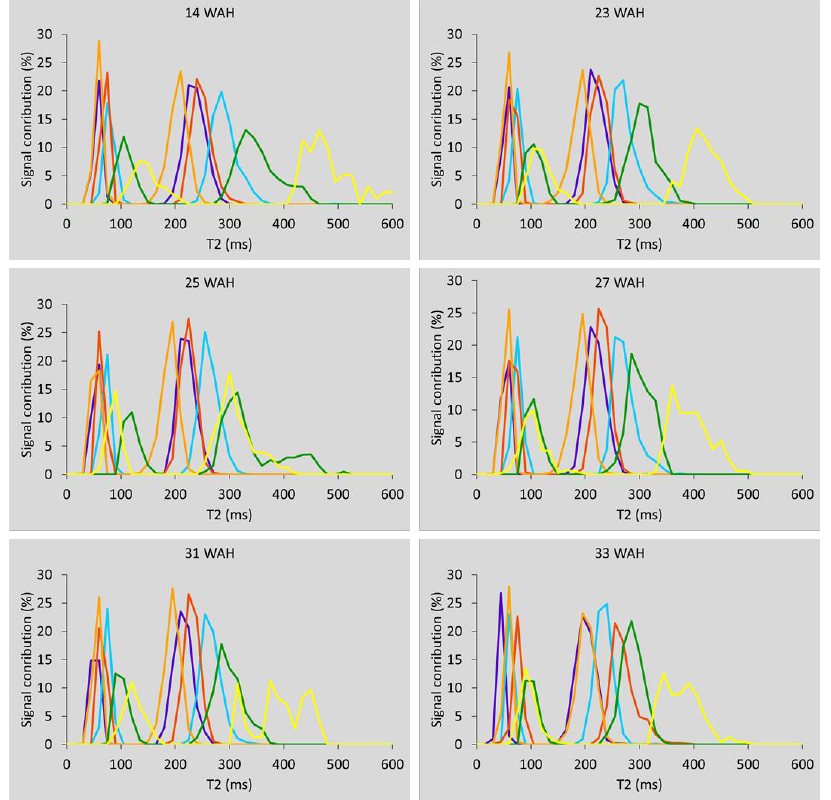
Figure 6. 𝑇 2 distribution for 14, 23, 25, 27, 31 and 33 WAH. Colors were attributed regarding both 𝑇 22 and spatial information as detailed in the text. On average, purple could be attributed to cortex, green to the pith and yellow to the defects, the three other colors, light and dark orange and cyan, to the flesh . The cortex (purple class) had low 𝑇 2 relaxation values coupled with high 𝑅 02 values. By contrast, the cyan class, located next to the cortex, had higher 𝑇 2 relaxation values and similar 𝑅 02 values. The light orange class had the lowest 𝑇 2 relaxation values, as well as the lowest 𝑅 02 values. The pith and the defects had similar 𝑇 2 values and the defects had lower 𝑅 02 values. With regard to the evolution of relaxation times, 𝑇 21 and 𝑇 22 values, for the defects, and 𝑇 22 values, for the pith, tended to decrease during storage, whereas these